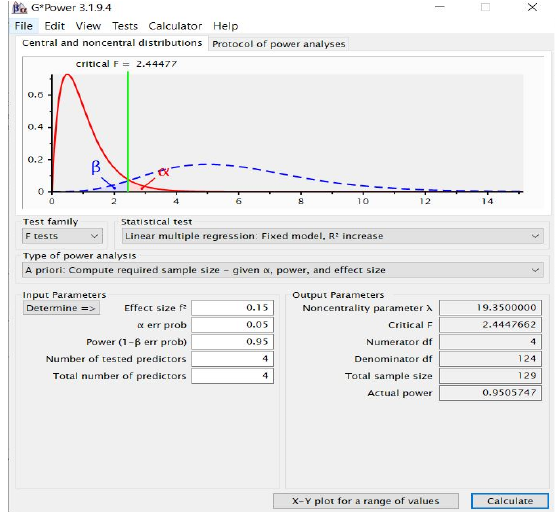
Figure 2. Power Analysis for Medium Effect